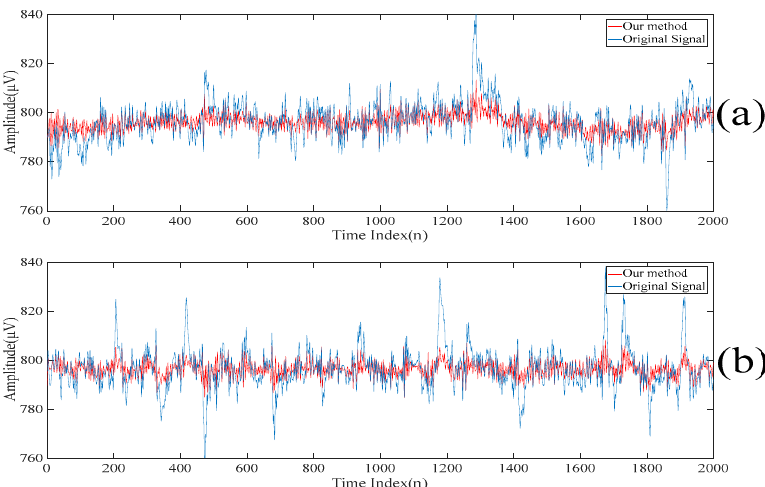
Figure 12. ( a ) The despiked electroencephalogram based on the same set of the threshold values for a new realization of an electroencephalogram. ( b ) The despiked electroencephalogram based on the same set of the threshold values for a new realization of an electroencephalogram.